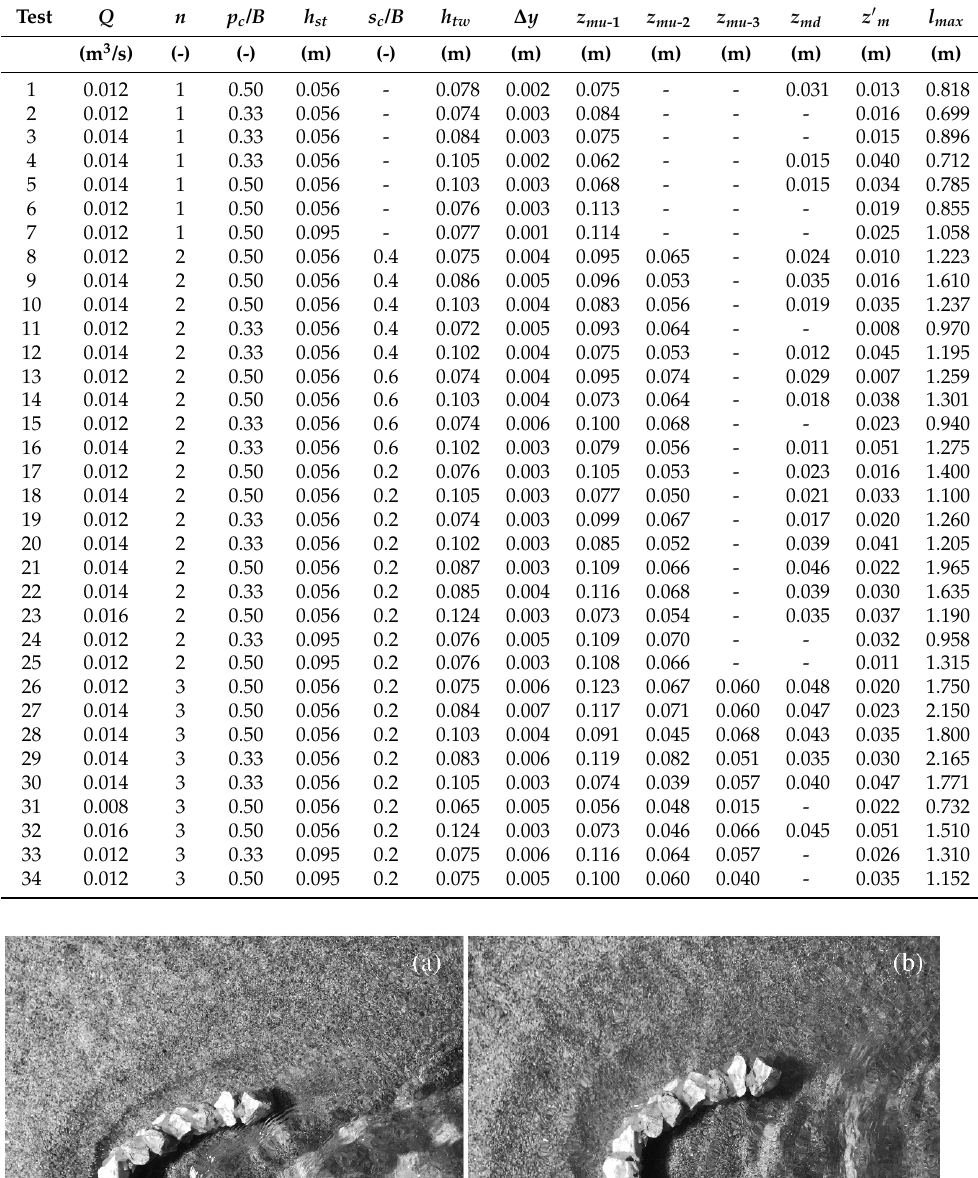
Table 1. Summary of experimental conditions and results.